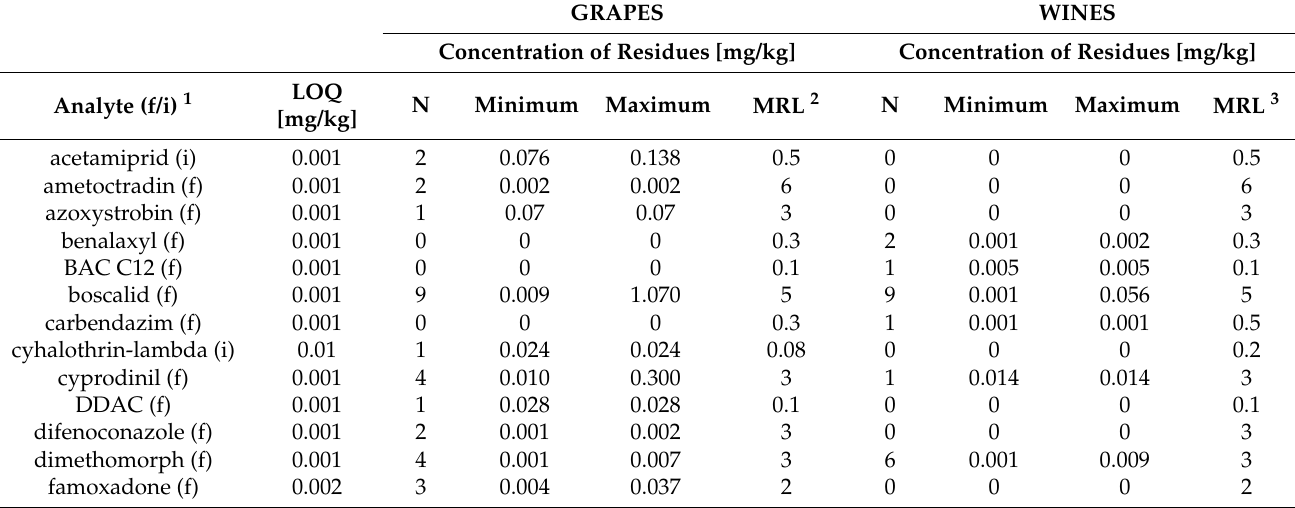
Figure 1. The number of quantifiable pesticide residues and detected pesticide metabolites in individual tested grapes and wines from conventional production. Table 2. The limits of quantification, MRLs and minimum and maximum concentrations of detected pesticides in tested grapes and wines from conventional